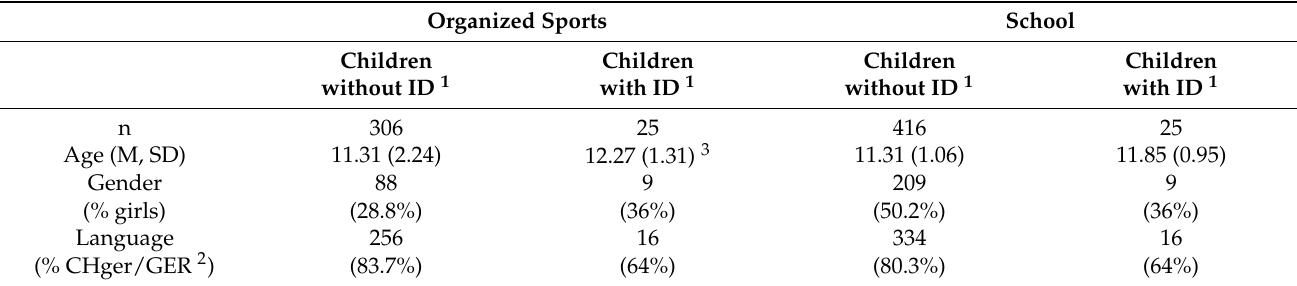
Table 1. Description of sample (N = 24 sports groups, N = 24 school